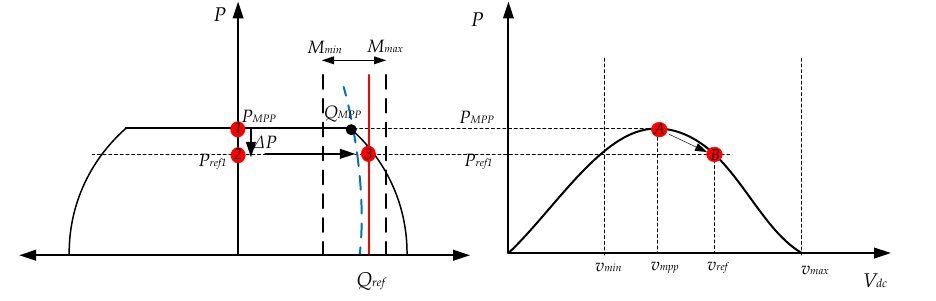
Figure 17. QPPT operation in a variable PQ and ambient conditions: Injection of reactive power. (1) MPP at one solar irradiance, (2) Variation of active power reference, (3) Reference of reactive